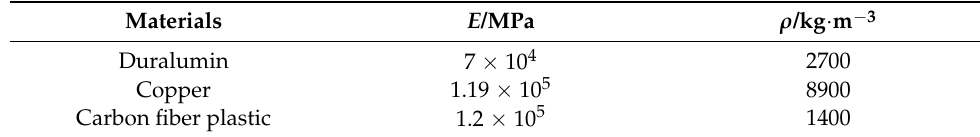
Table 5. Parameters of different materials.